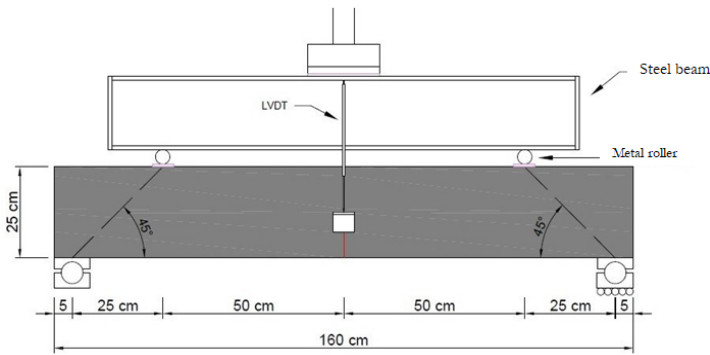
Figure 1. Schematic of the four-point bending test carried out on the